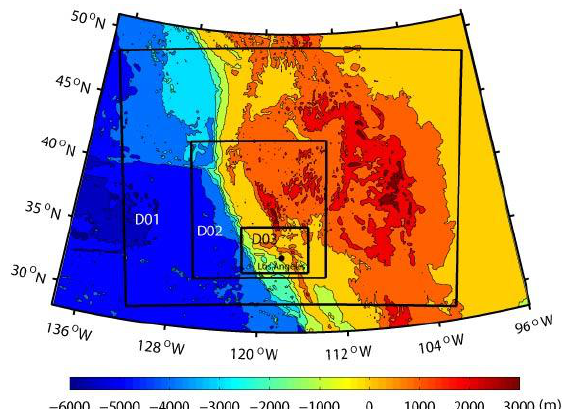
Figure 2 Three-nested model domains. The black square indicates the location of Los Angeles. Colors indicate topographic